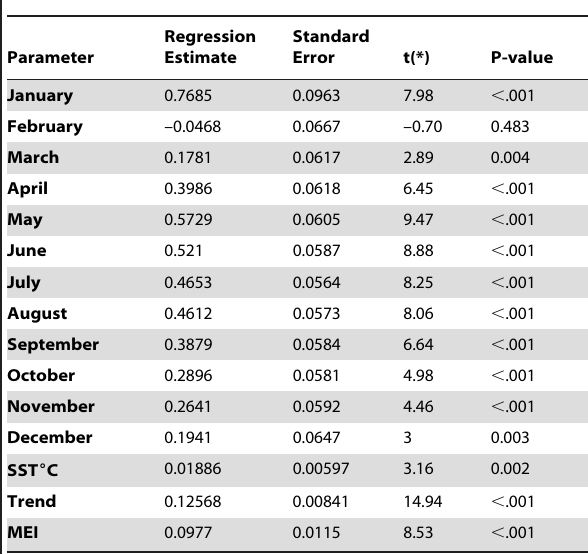
Table 4. Results of a generalized linear model relating total number of great white sharks observed per trip in Gansbaai to specified explanatory variables.